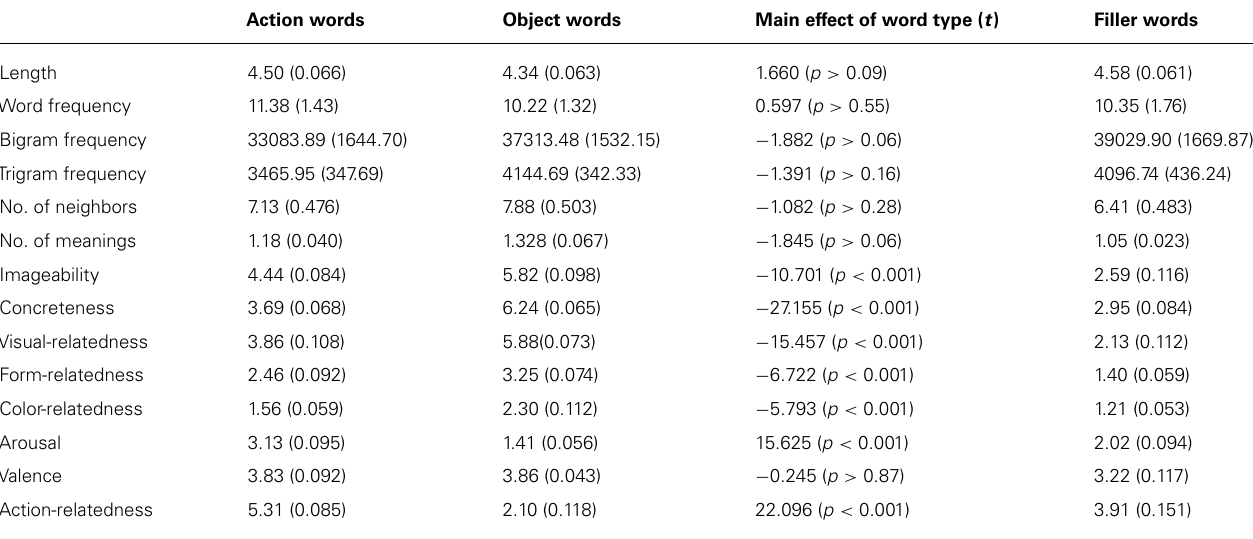
Table 1 | Psycholinguistic and semantic features of word